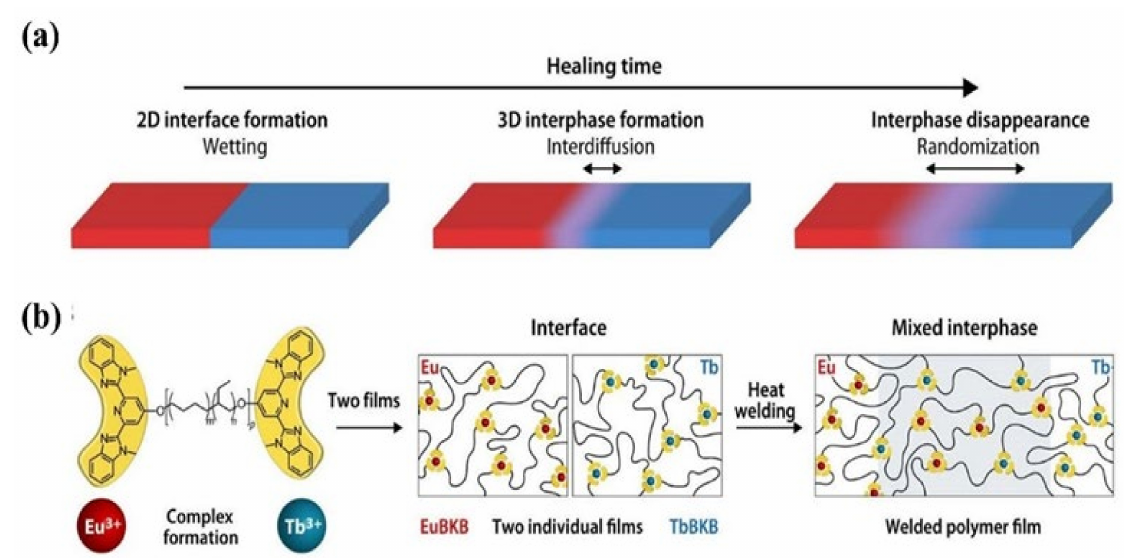
Figure 2. The healing process in polymers. ( a ) The final stages of the healing process in polymers involve wetting, interdiffusion with re-entanglement, and randomization. ( b ) To investigate the healing process on a length scale of a few nanometers, metallosupramolecular polymers (MSPs) assembled from telechelic PEB with terminal Mebip ligands ( Mn = 3800 g mol − 1 ; m ≈ 0.32, n ≈ 0.68, p ≈ 55) and either Eu(ClO 4 ) 3 or Tb(ClO 4 ) 3 were studied. The two metallosupramolecular polymers display similar properties, but the different ion types can be monitored in a spatially resolved